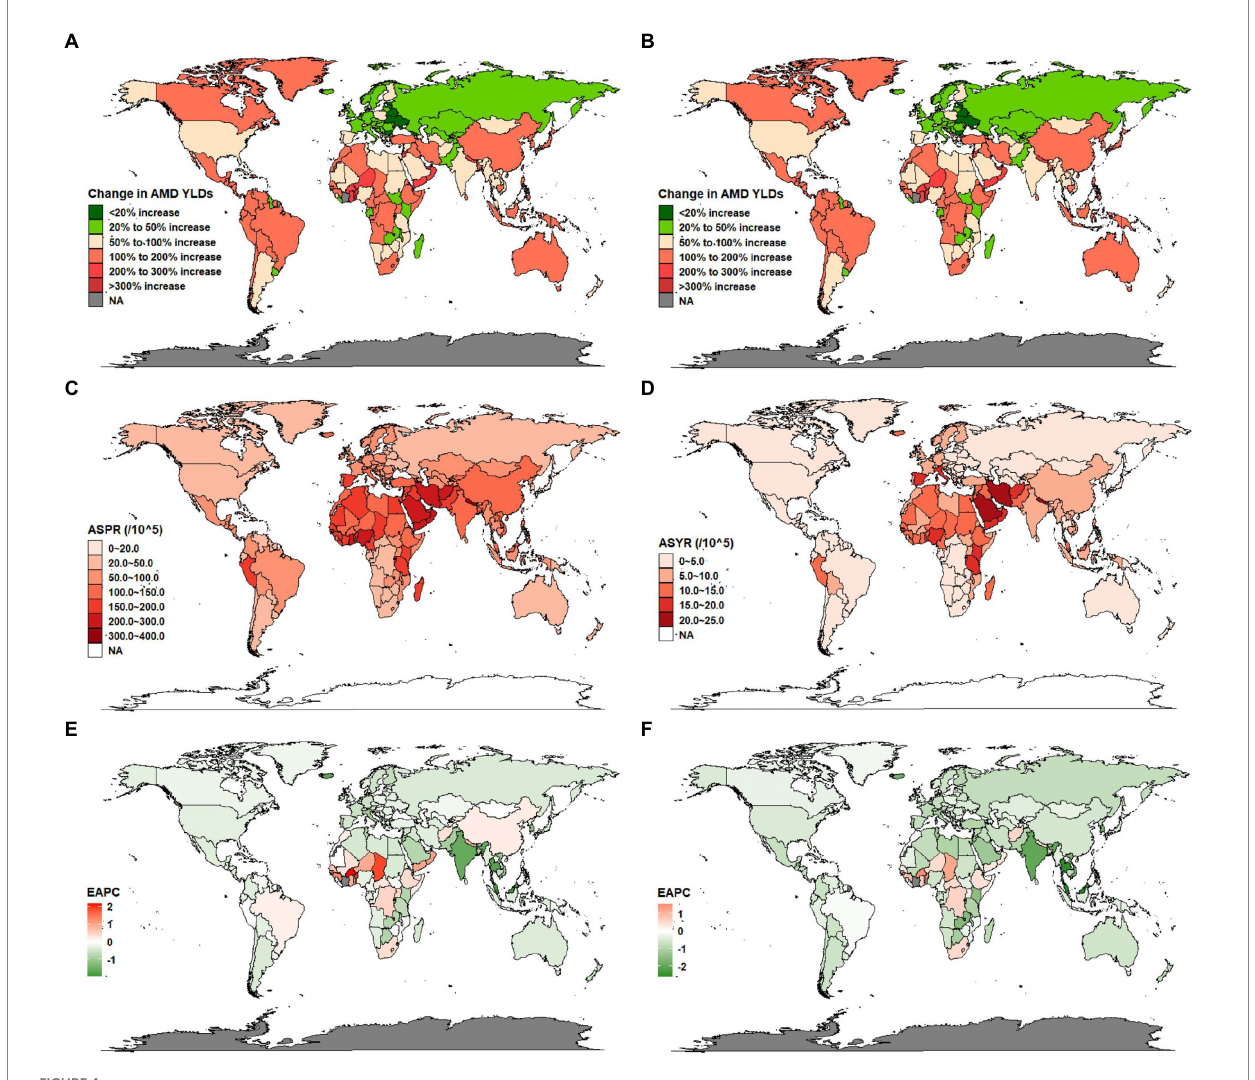
FIGURE 4 Global burden of the prevalence and YLDs of AMD in 204 countries and territories. (A) The growth rates of AMD cases from 1990 to 2019. (B) The growth rates of AMD YLDs from 1990 to 2019. (C) The ASPR of AMD in 2019. (D) The ASYR of AMD in 2019. (E) The EAPC of ASPR for AMD from 1990 to 2019. (F) The EAPC of ASYR for AMD from 1990 to 2019. AMD, age-related macular degeneration; ASR, age-standardized rate; EAPC, estimated annual percentage change; YLDs, years lived with